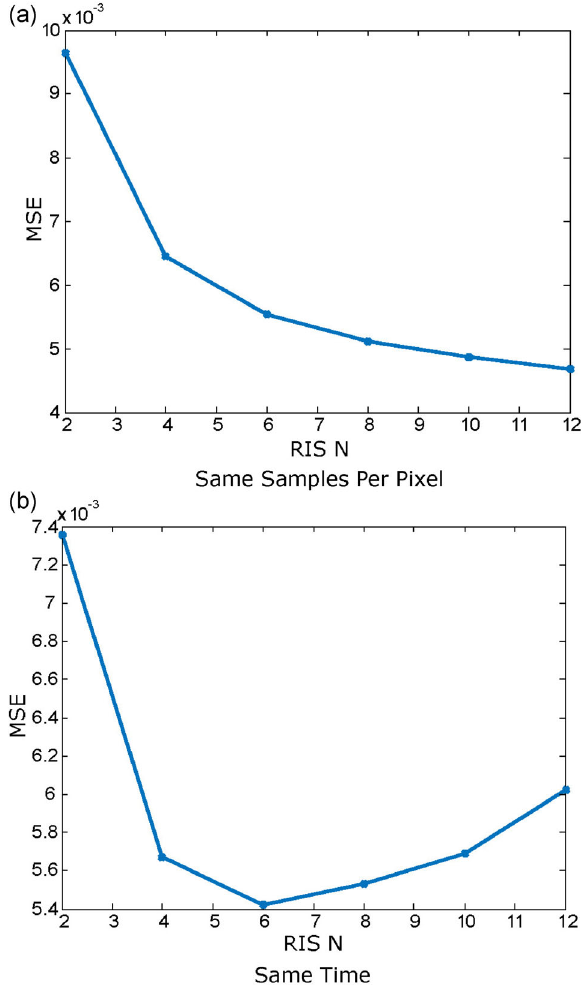
Fig. 18 Error (MSE) as a function of resampling sample count with equal samples per pixel (spp: 1029) (a) and equal time (30 minutes) (b) for the Candle